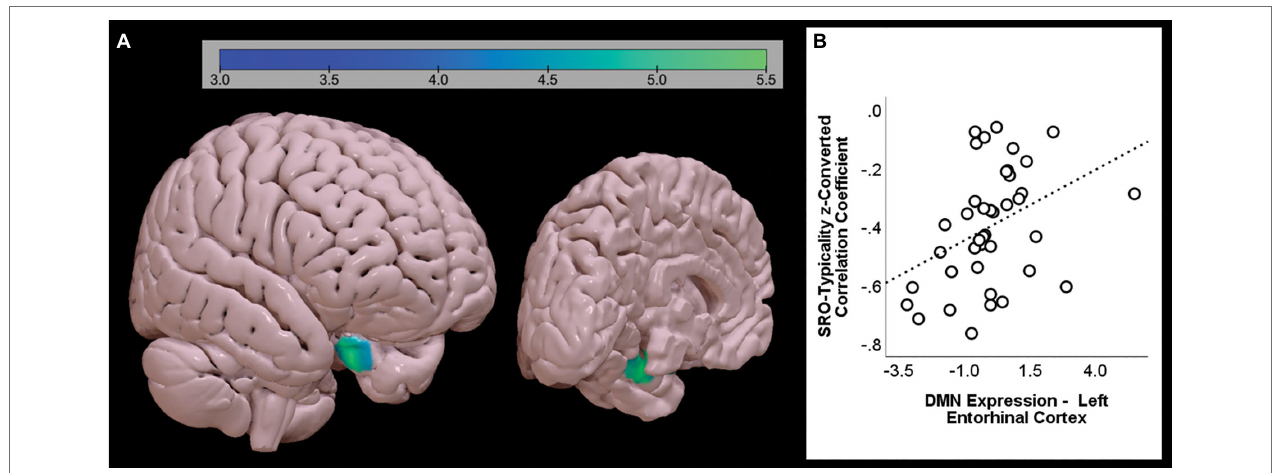
FIGURE 6 | Significant positive association between SRO-typicality and DMN expression, as emerging from the second set of models aimed at identifying the unique pattern of variability accounted for by each index. A single cluster is shown from two different angles (A) . The association between the coefficient and the strength of the DMN extracted from the cluster is shown on the right-hand side (B) . The graph shows the uncorrected association between the two variables (standardised β = 0.386).